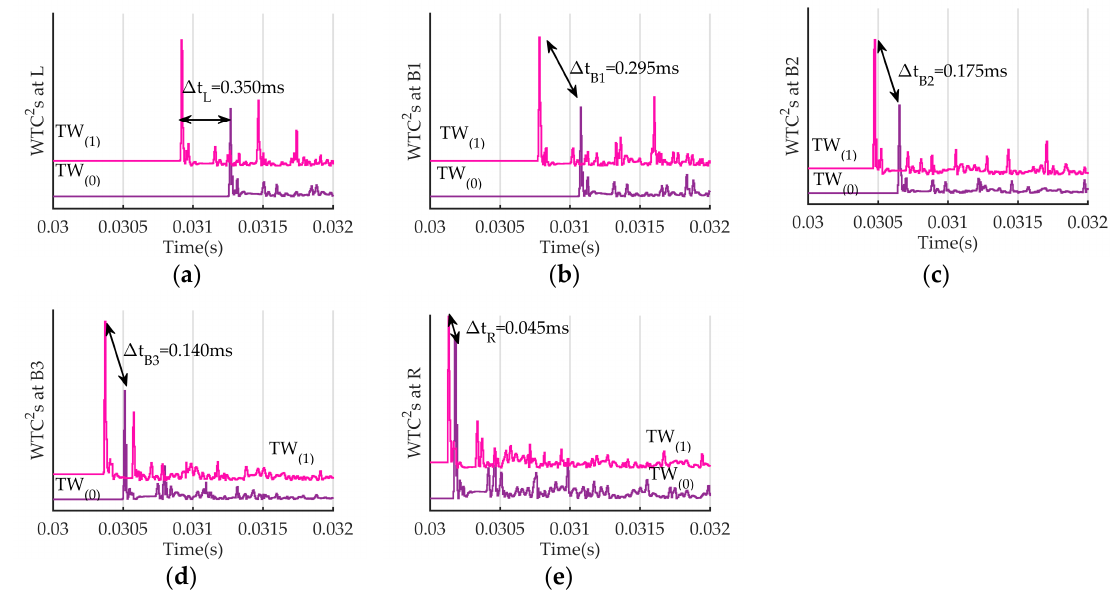
Figure 10. WTC 2 for ground and aerial mode waves and arrival time difference at each terminal. ( a ) Measured at terminal L; ( b ) Measured at terminal B1; ( c ) Measured at terminal B2; ( d ) Measured at terminal B3; ( e ) Measured at terminal